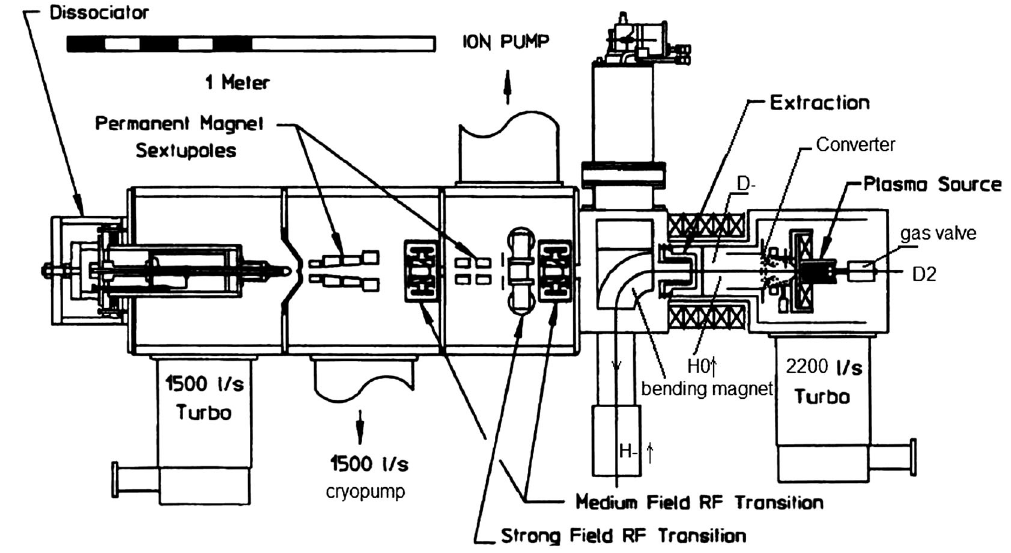
FIG. 13. Schematic diagram of ABPIS with resonant charge-exchange ionization